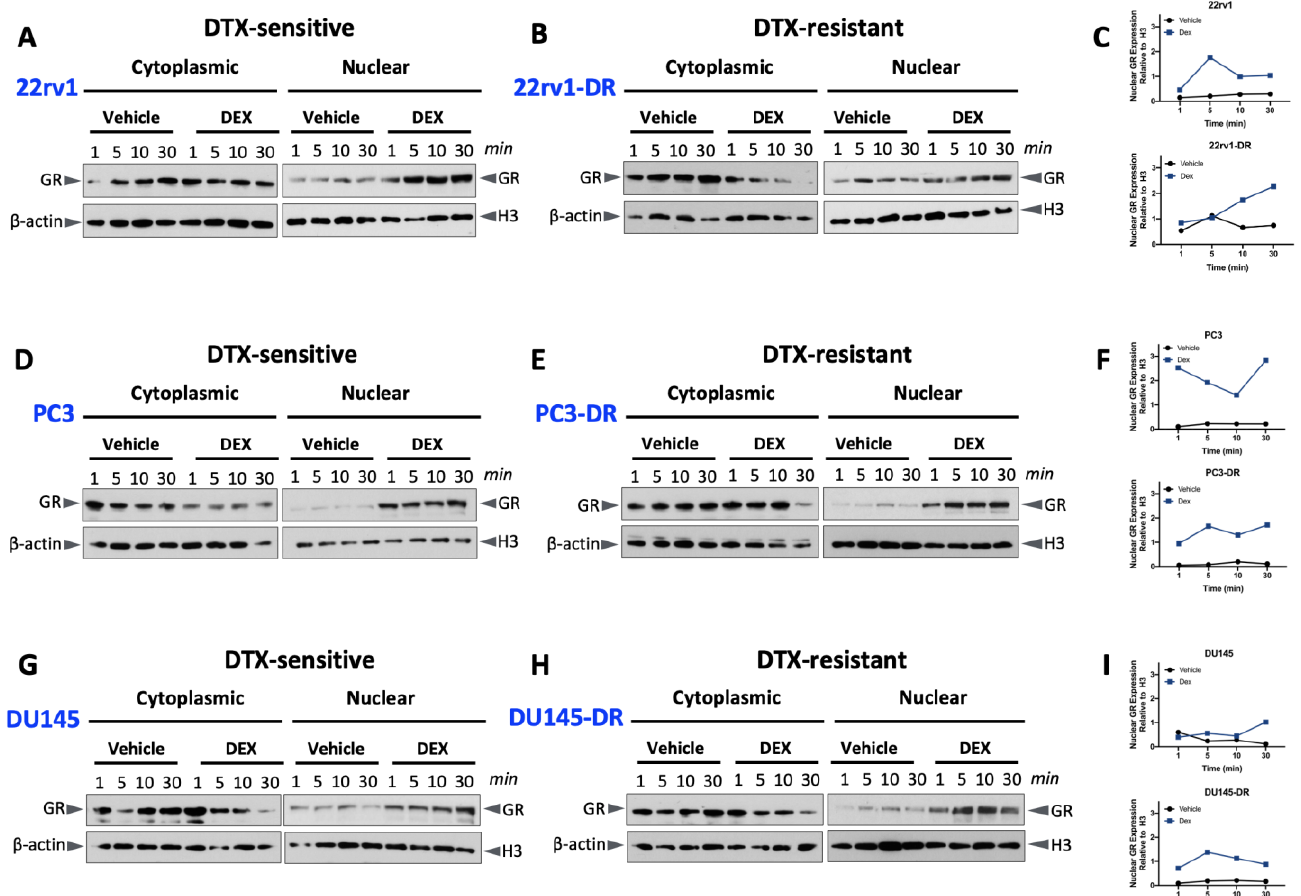
Figure 2. GR nuclear translocation in DTX-sensitive and DTX-resistant PCa cells in response to dex- amethasone . DTX-sensitive and DTX-resistant 22rv1 ( A , B ), PC3 ( D , E ), and DU145 ( G , H ) cells were cultured in medium depleted of glucocorticoids (containing CS-FBS) for 12 h prior to treatment with 10 nM dexamethasone for 1, 5, 10, or 30 min, and subcellular cytoplasmic and nuclear proteins were extracted. The blots included in this figure were quantified to show nuclear GR expression in dexa- methasone-treated cells (blue squares) compared to vehicle-treated cells (black circles) ( C , F , I ). GR and the loading controls β-actin (cytoplasmic) and histone H3 (nuclear) were detected by immunob- lotting.